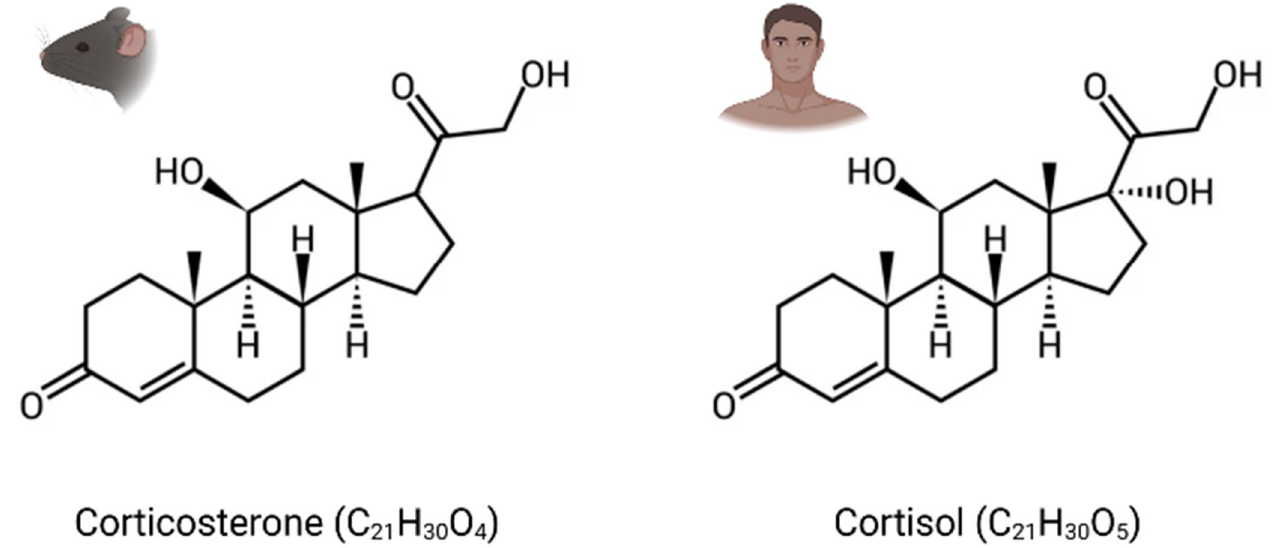
Figure 1. Chemical structure of glucocorticoid hormones (GCs). Corticosterone: corticoid present in rodents. Cortisol: corticoid present in humans.